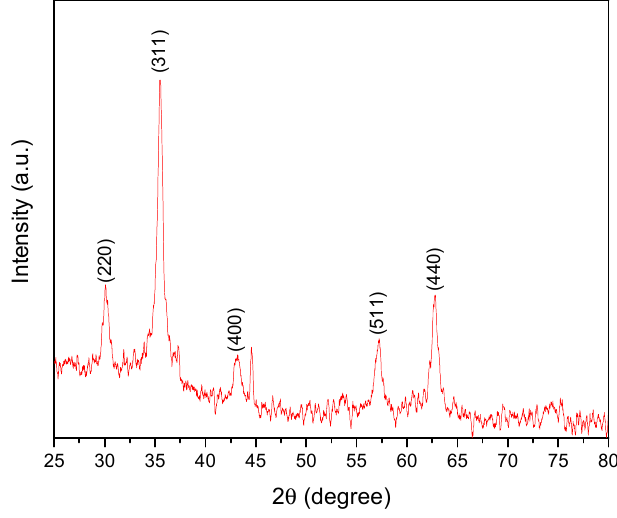
Figure 5. XRD pattern of synthesized Fe 3 O 4 NPs.